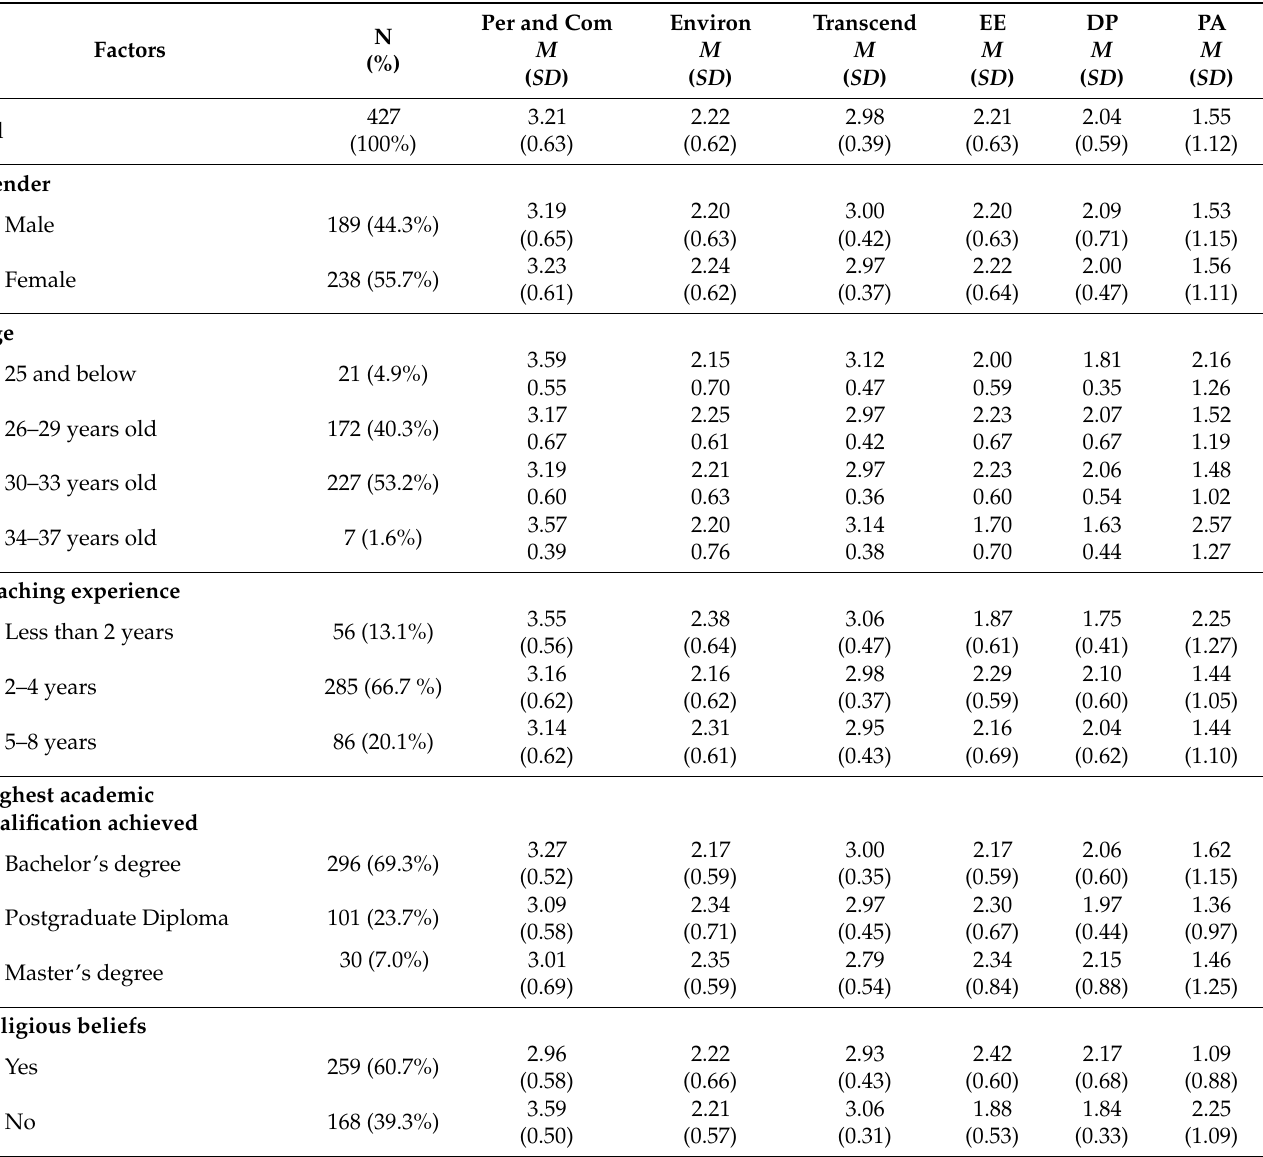
Table 3. Descriptive statistics: Participants’ demographics and their relationship with spiritual well-being and burnout ( N =